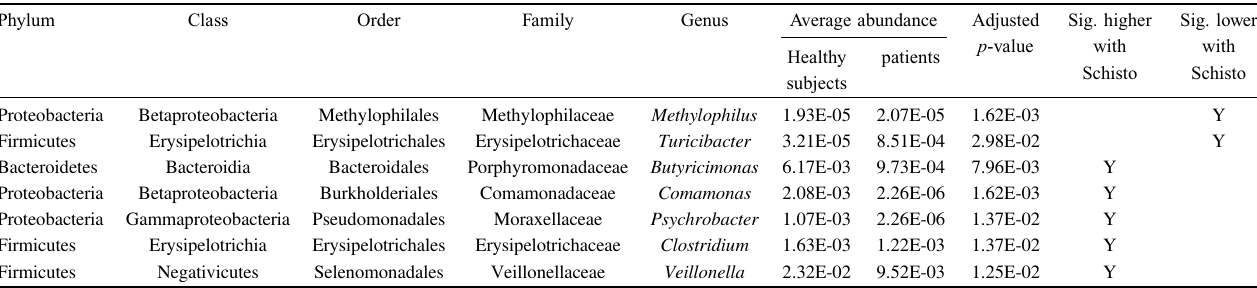
Table 2. The relative abundance of differentially abundant taxa based on DESeq2